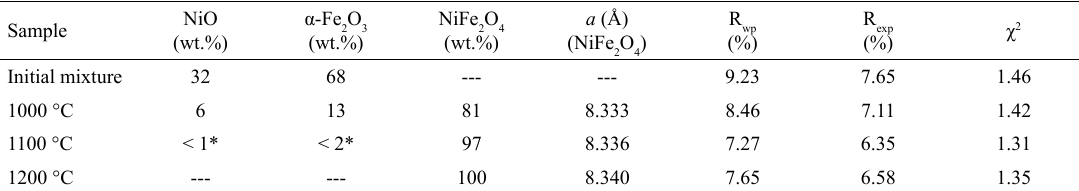
Table 1. Variation with temperature of the relative abundances and of the lattice parameter of NiFe parameters χ 2 , R and R were obtained from the Rietveld analysis of the XRD patterns. Estimated errors are of about 1 wt. % for the wp exp phase abundances and of 0.001 Å for the lattice parameters.